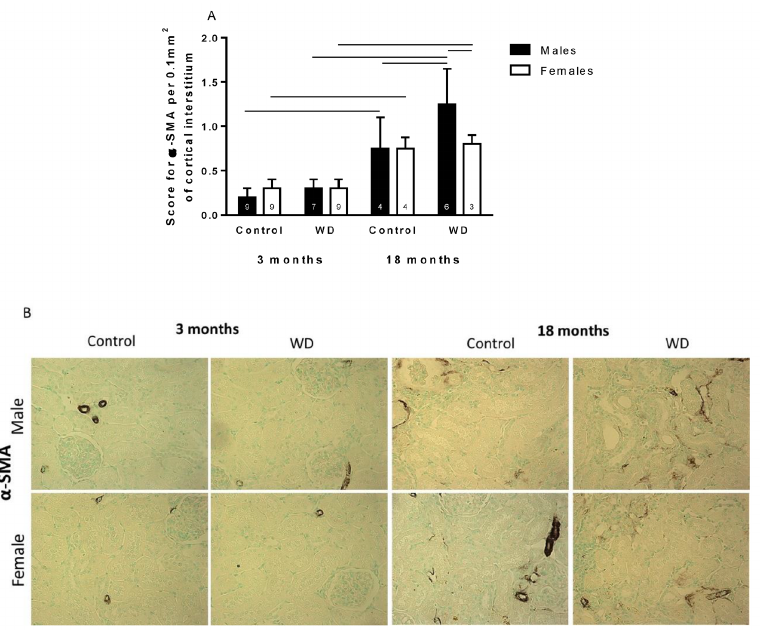
Figure 2. Score ( A ) and representative images ( B ) for α -SMA per 0.1 mm 2 of cortical interstitium in control and water-deprived (WD) 3- and 18-month-old male and female rats (magnification 400×). Data are expressed as median and interquartile range (25–75th) ‘_____’: p < 0.05 among the indicated groups. Factorial ANOVA followed by Newman–Keuls post-test. Number (n) of animals is indicated inside the column.